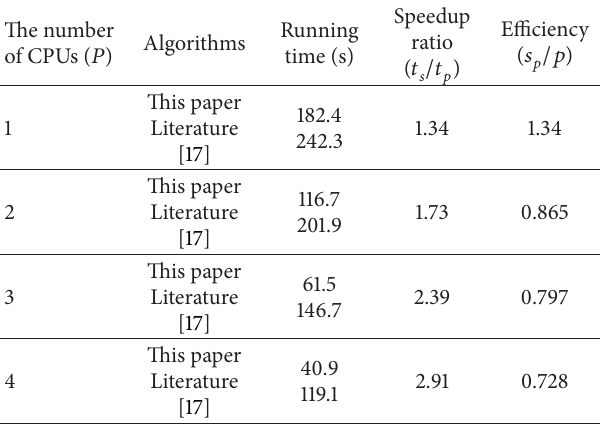
Table 4: Performance of parallel algorithm in running time, speedup ratio, and efficiency with the different number of CPUs ( 𝑀 = 𝑁 = 20